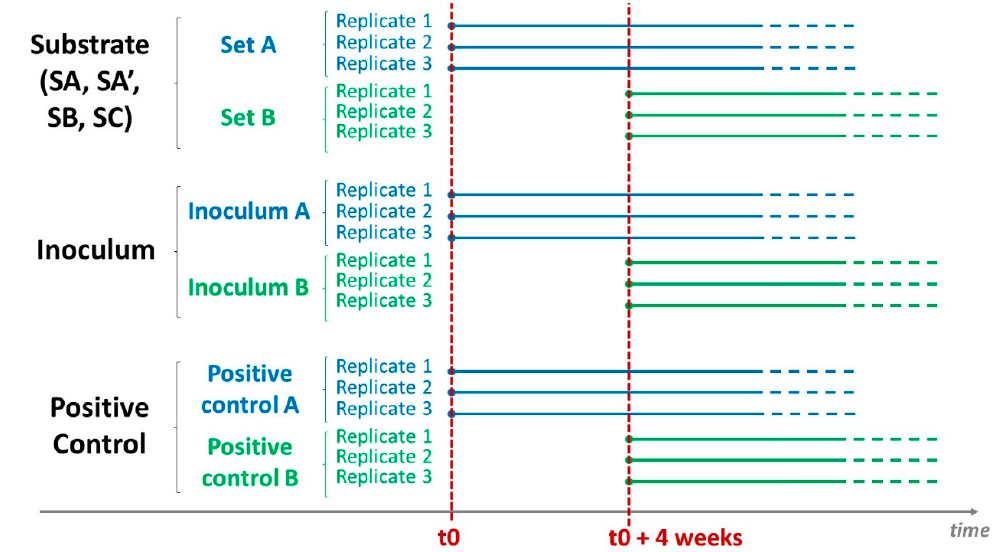
Figure 2. Schematic and organizational schedule of the inter-laboratory study; this process was carried out twice (phases 1 and 2).